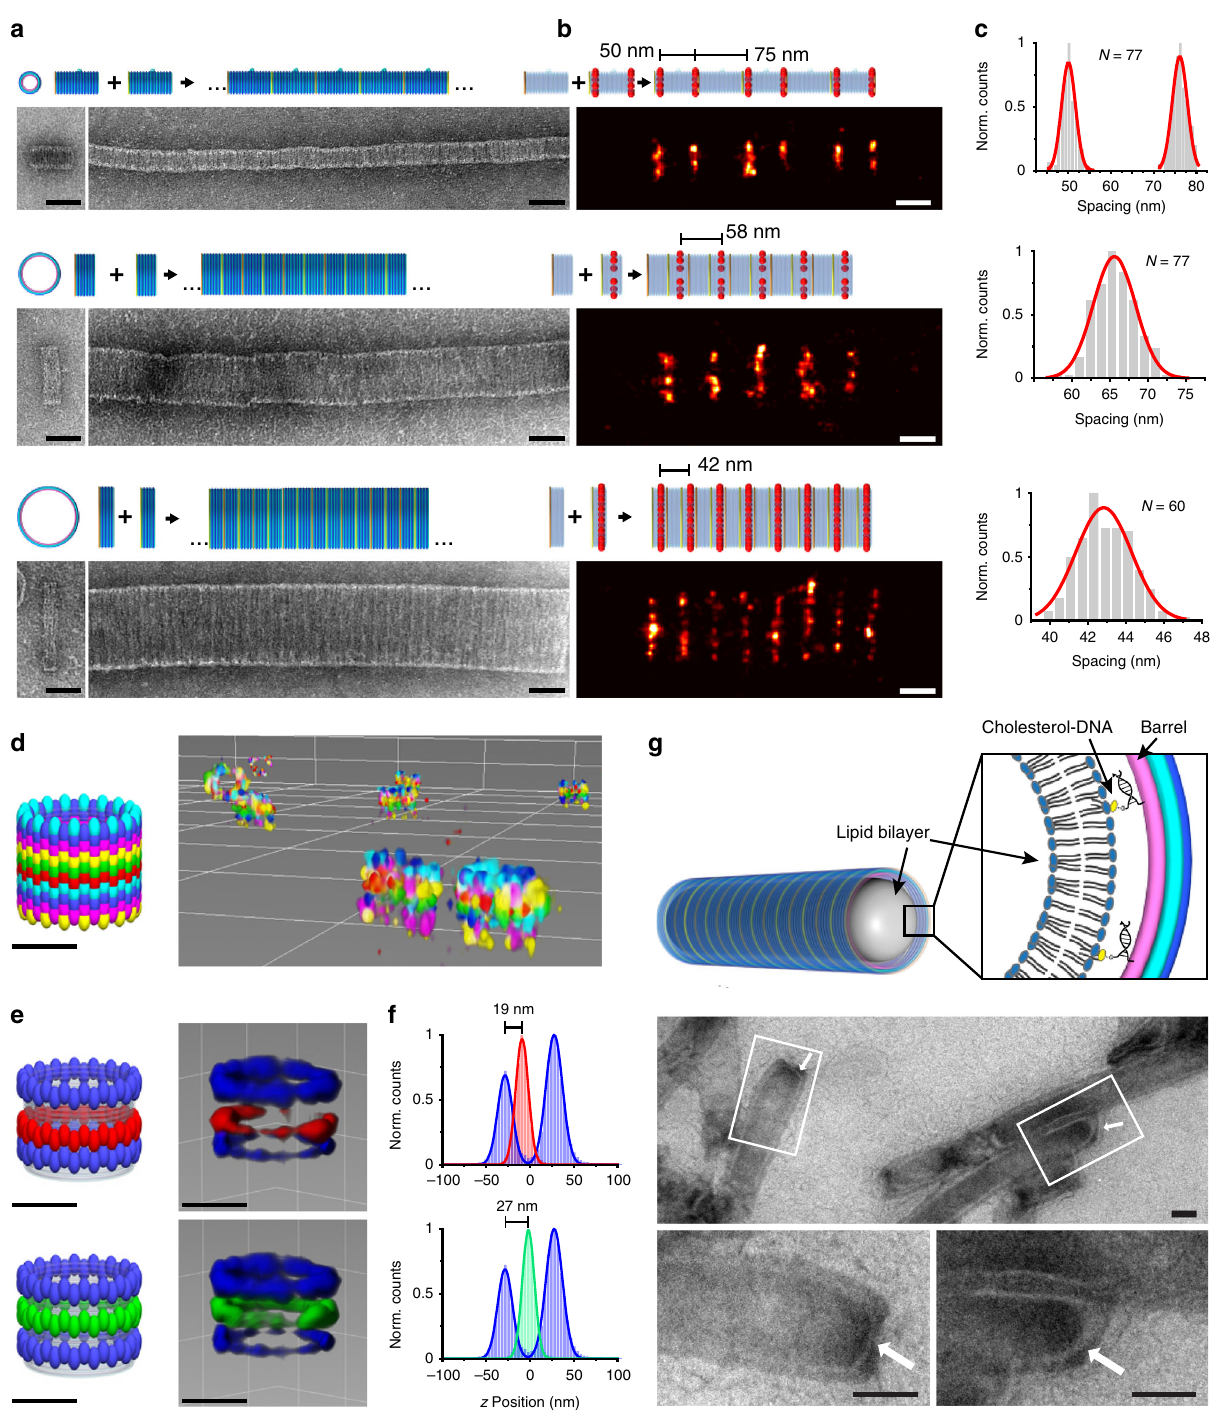
Fig. 3 DNA-origami barrel polymers assembled from repeating α and β monomers. a Models of barrel polymers illustrating placement of DNA-PAINT docking handles. 30-nm barrel design: α monomer with two DNA-PAINT rings spaced 50 nm apart, and αβ repeating height of 125 nm; 60-nm barrel design: α monomer with one DNA-PAINT ring and αβ repeating height of 58 nm; 90-nm barrel design: α monomer with one DNA-PAINT ring and αβ repeating height of 42 nm. b DNA-PAINT images of representative polymers with corresponding models listing designed spacings above. (Scale bars in a and b are 50 nm). c Histograms of measured spacings of DNA-PAINT rings. d Model of 90-nm barrel αβα trimer with four DNA-PAINT rings for each monomer, showing DNA-PAINT images of individual particles (colors for α : cyan, blue, magenta, yellow, colors for β : yellow, green, red, cyan). e Composite sum image (outer ring docking sites: X4, X5, X6, X1, X2, X3, X4, X5, X6, Supplementary Table 9). 3D model (left) shows designed ring spacing of 17 and 26 nm. f Histogram of distances between DNA-PAINT rings, measured ring spacing of 19 ± 10 and 27 ± 10 m. g Negative-stain TEM images of lipid nanotubes reconstituted within the interior of 90-nm barrel polymers. Scale bars are 50